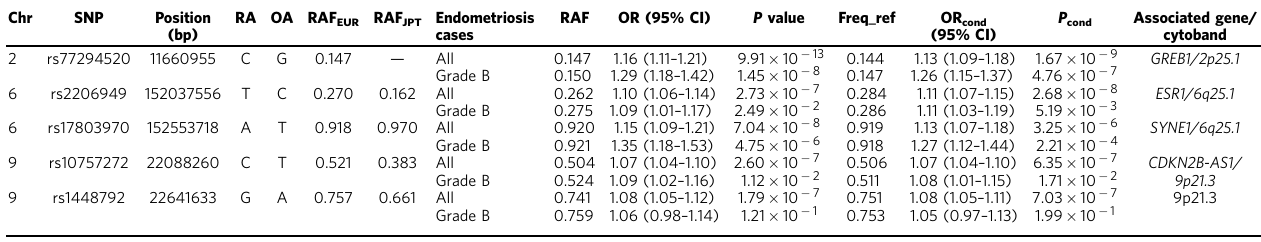
Chr, Chromosome; SNP, single-nucleotide polymorphism; Genomic position is shown related to GRCh37 (hg19); Freq_ref, frequency of the risk allele in the reference sample; LD, linkage disequilibrium; RA,riskallele;OA,otherallele;RAF, OR(95%CI)and P, riskallelefrequency,oddsratioand95%confidenceinterval, and P valuefromthe meta-analysis;OR cond (95%CI)and P cond ,oddsratioand95% confidence interval, and P value from conditional analyses; RAF EUR , risk allele frequency in Europeans; RAF JPT , risk allele frequency in Japanese;.